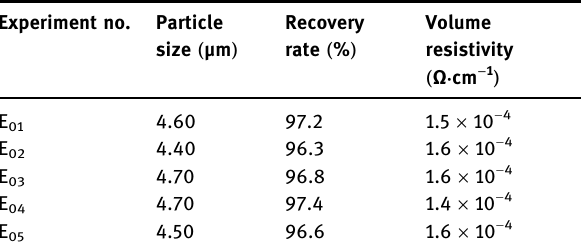
Table 2: Characterization of as - synthesized micro - size fl ake